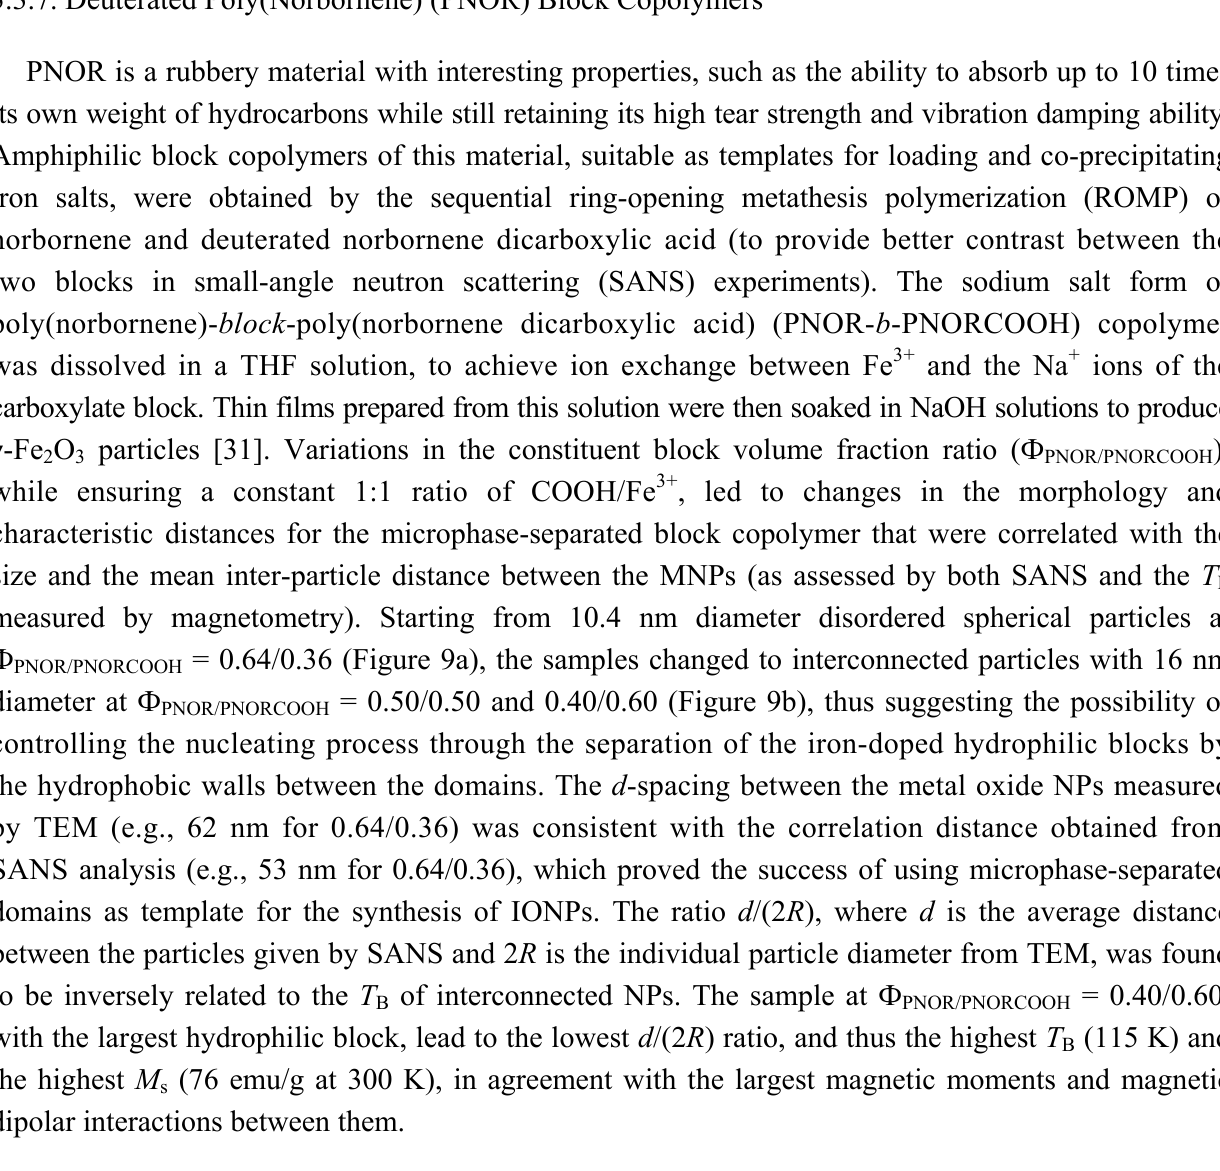
Figure 9. Morphology of poly(norbornene- block -deuterated norbornene dicarboxylic acid) = 0.64/0.36 (disordered spheres); loaded with iron oxide NPs (IONPs) at: ( a ) Ф PNOR/PNORCOOH and ( b ) Ф = 0.40/0.60 (interconnected spheres). PNOR: poly(norbornene); PNOR/PNORCOOH and PNORCOOH: poly(norbornene dicarboxylic acid). Reprinted with permission from [31]. Copyright 2005 Elsevier